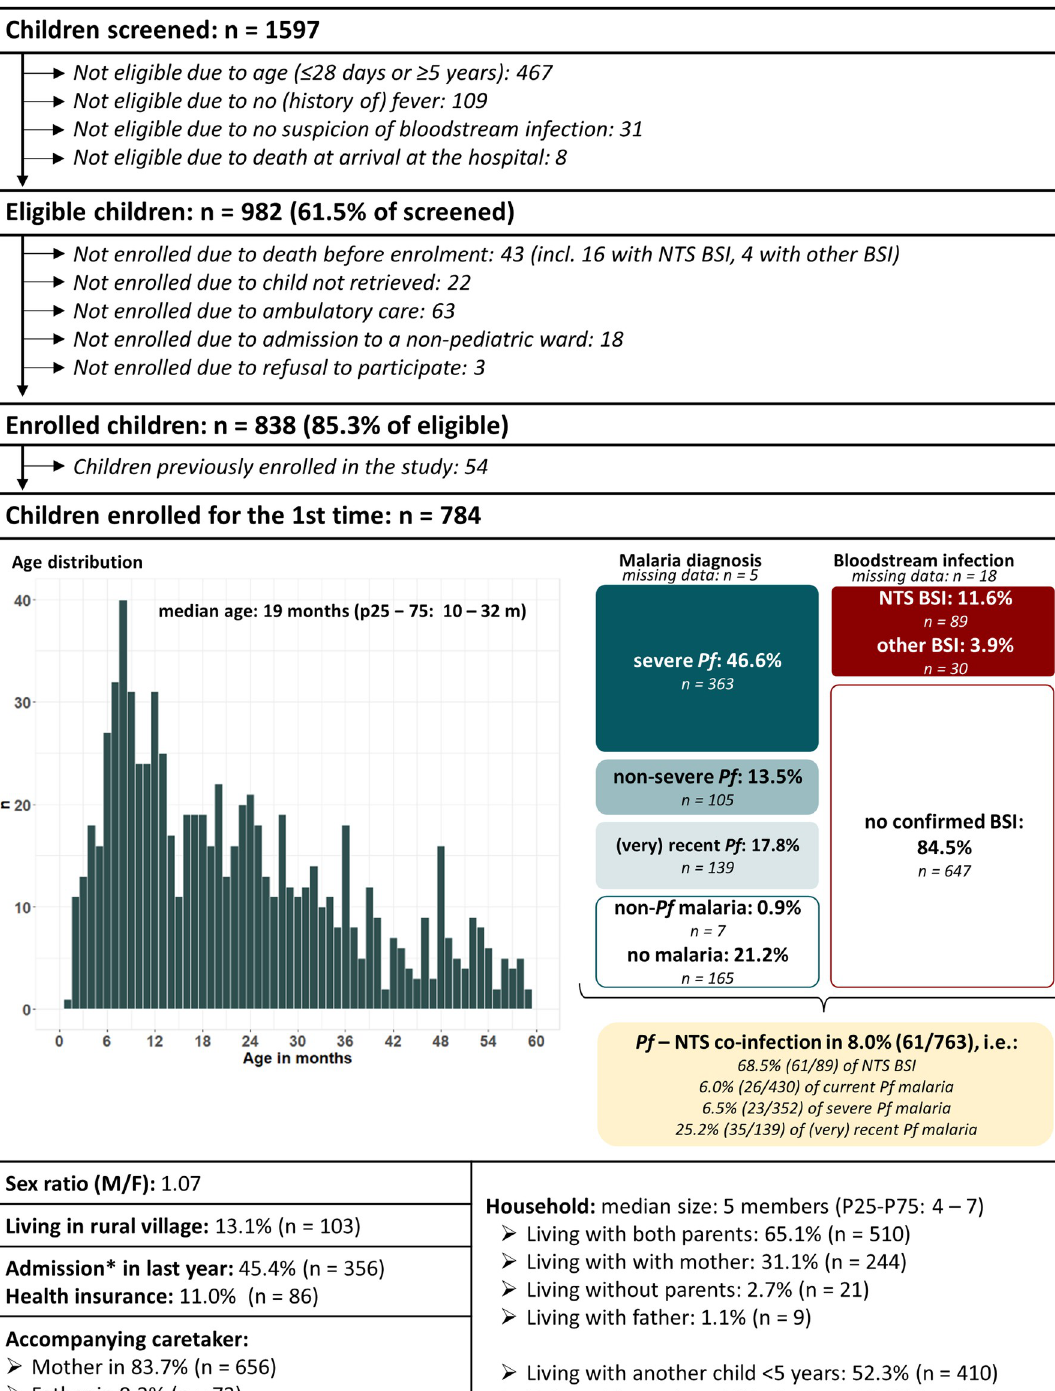
PLOS NeglectedTropical Diseases | https://doi.org/10.1371/journal.pntd.0011156 March 6, 2023 6 /